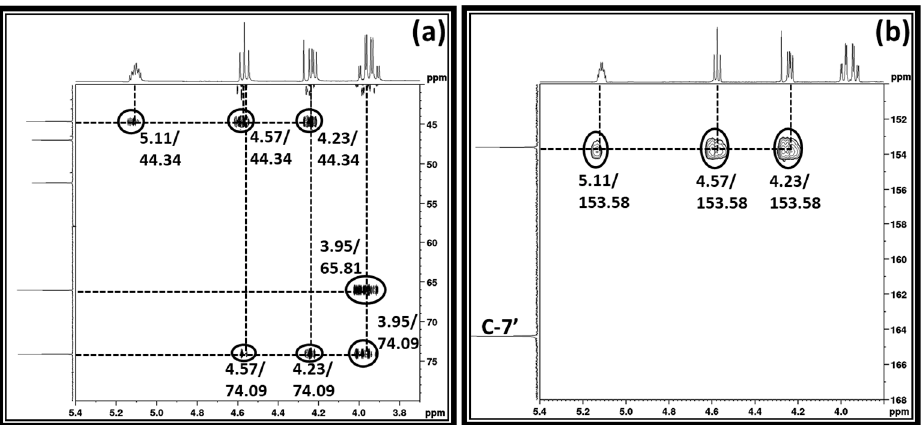
Figure 3 . ( a , b ) 1 H- 13 C HMBC NMR spectra of the reaction mixture after equivalent interaction of 1,3-dichloro-2-propanol, DBU and CO 2 in DMSO.